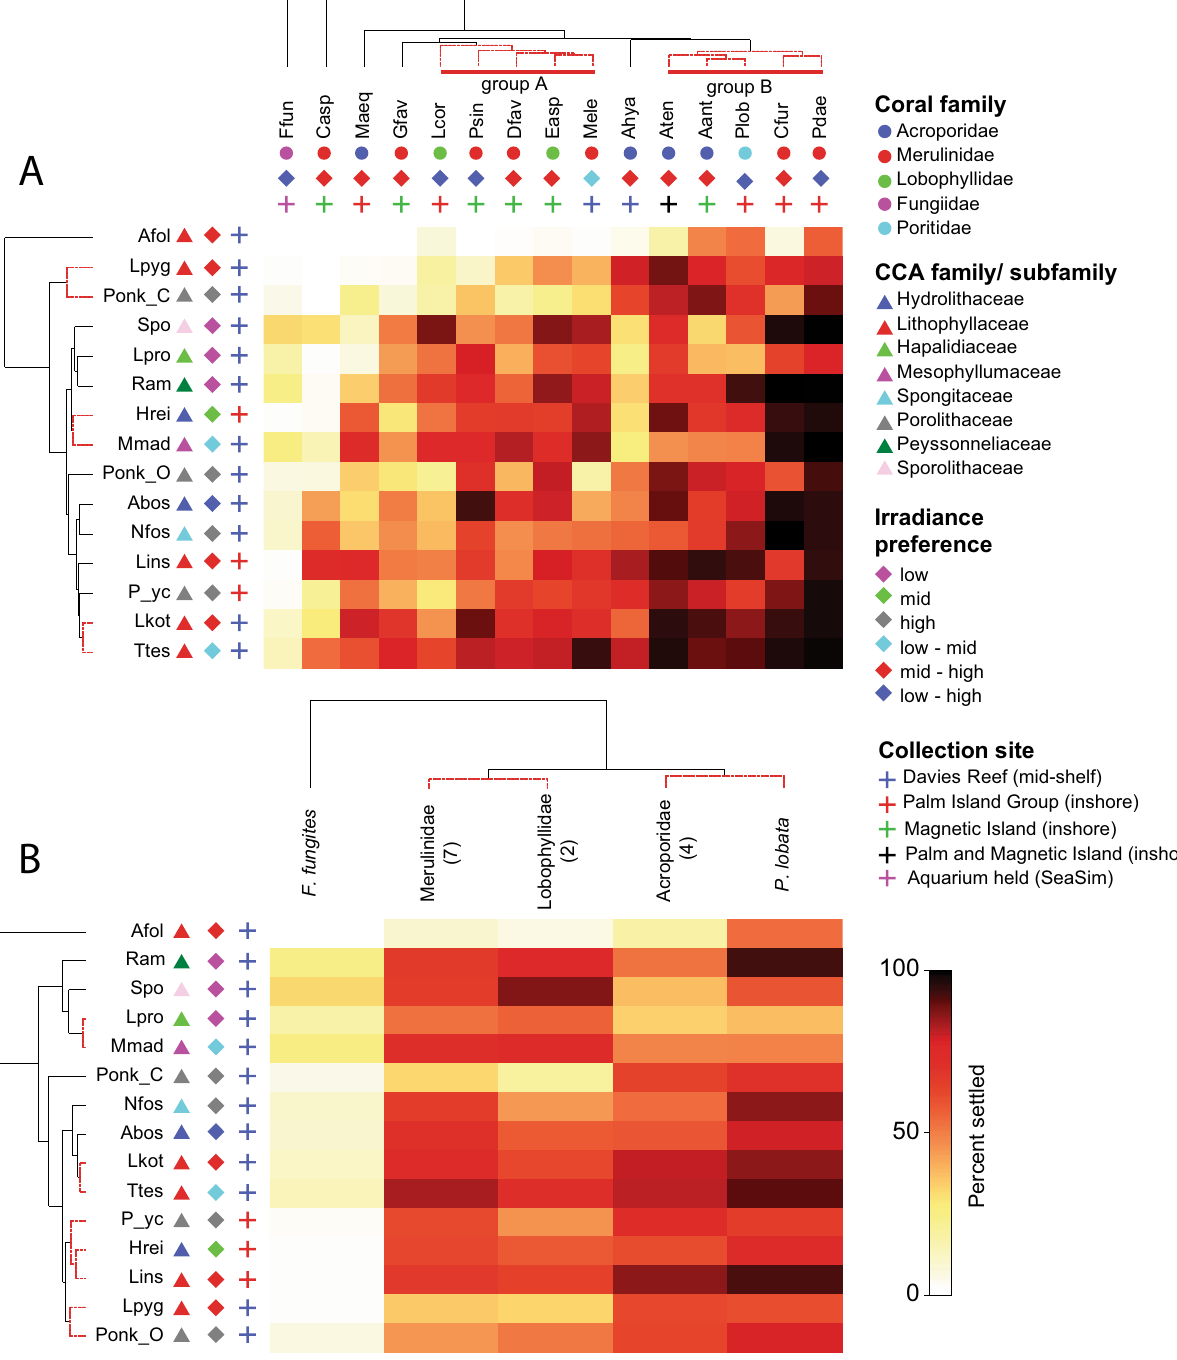
Figure 3. Shade plots ordered by cluster analyses dendrogram of coral and CCA taxa at the ( A ) coral species level and ( B ) coral family level (number of species represented per family indicated in parentheses). Cluster analyses were performed using the Bray–Curtis resemblance matrix for coral taxa and index of association matrix for CCA taxa, on the total settlement data averaged at the coral species and family level. Red dashed lines on the coral and CCA dendrograms reflect distinct groups as determined by SIMPROF analyses. Symbols corresponding to CCA and coral taxonomic families, irradiance preferences and collection sites (see legend) are included after the species abbreviations (See Table 3 for full species